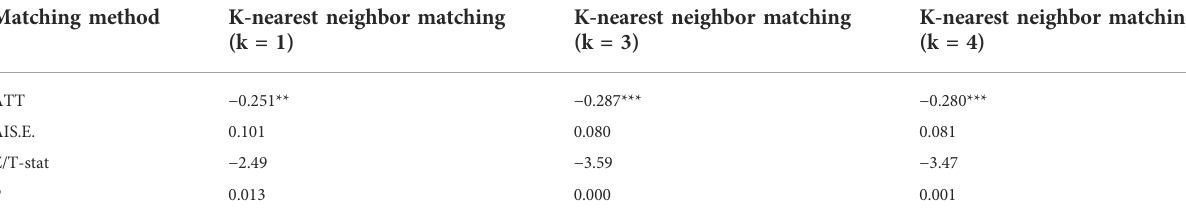
TABLE 3 ATT estimation results (based on Teffects psmatch command).